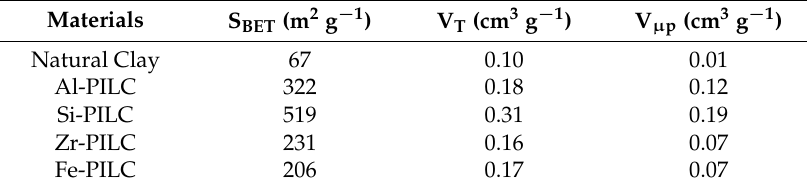
Table 1. Textural properties data and d 001 obtained for natural and pillared clays.